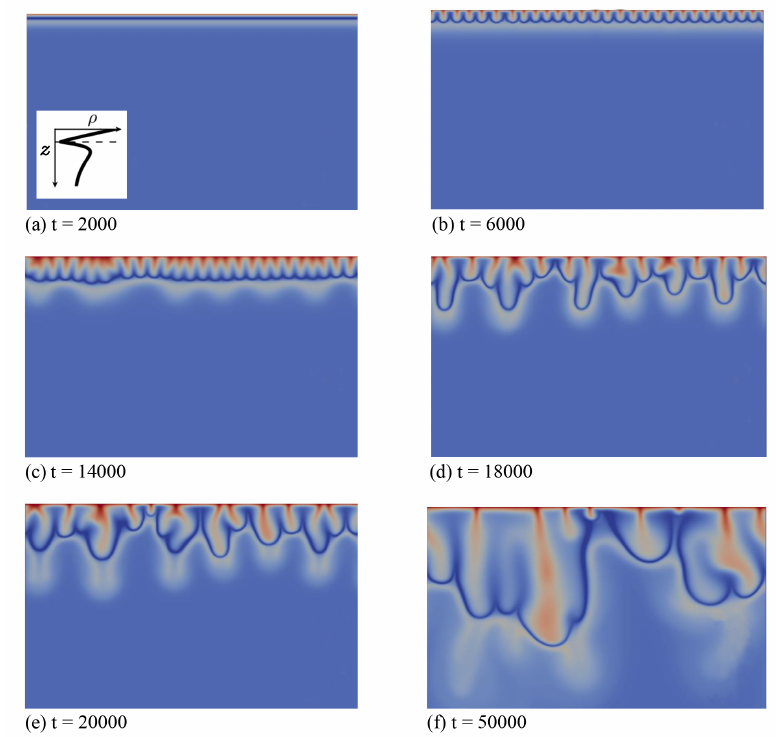
Figure 4. Density fields at different times ( a – f ) illustrating the fingering dynamics in Zone IV for the density profile enclosed in the first panel ( δ B = 0.3, δ C = 1 and R B = 1). The density scale varies between 0.87 (dark blue) and 1.8 (red).